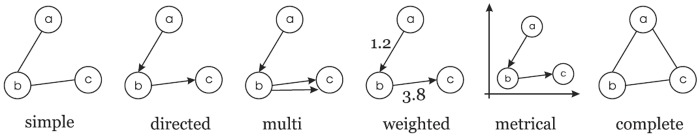
Graph types.Examples of different graph types.